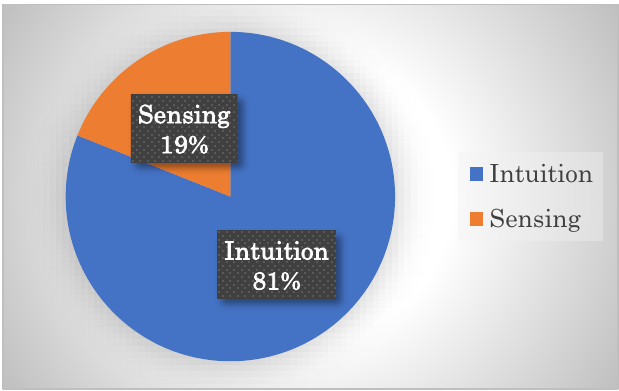
Fig. 3. Distribution of Class B in the